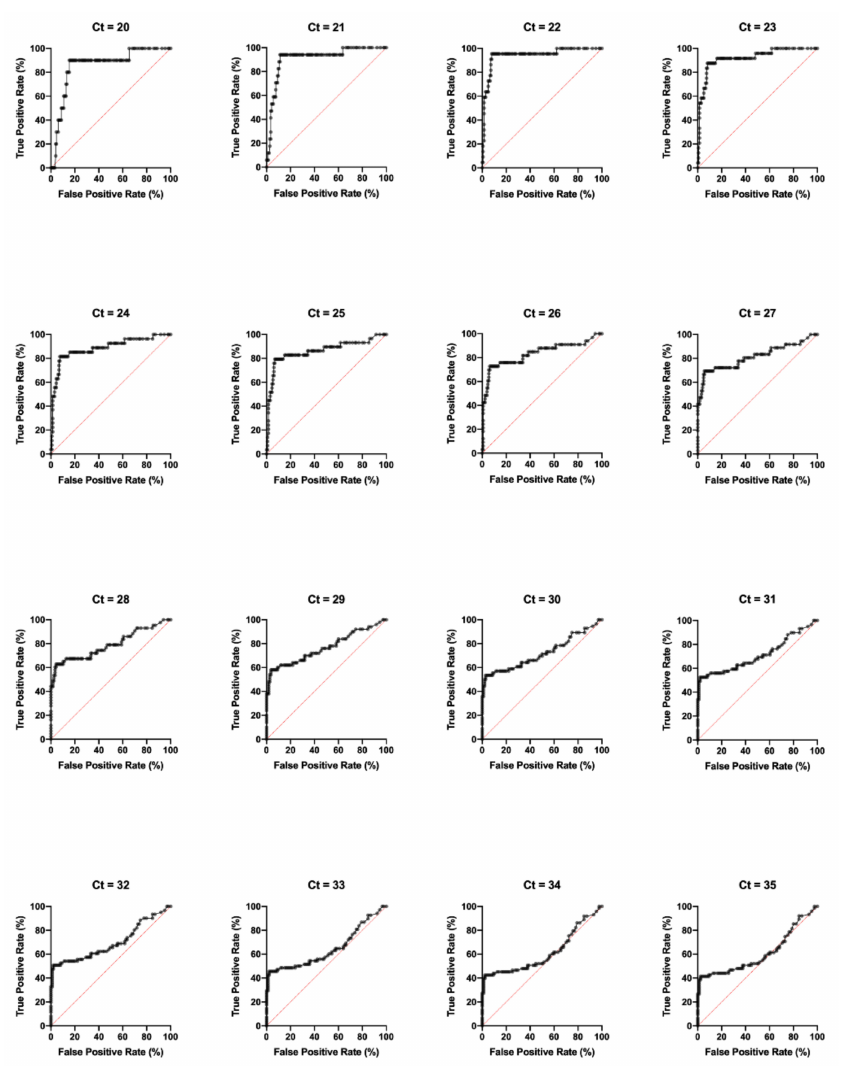
Figure 2. Performance of CHIKV E1 / E2 ELISA Test. Receiver operating characteristic (ROC) curve analysis of PCR-tested patient samples from Honduras. Incremental Ct values are used to characterize positive and negative samples, to which ELISA performance is compared. Test performance is demonstrated in terms of true positive rate (%) versus false positive rate